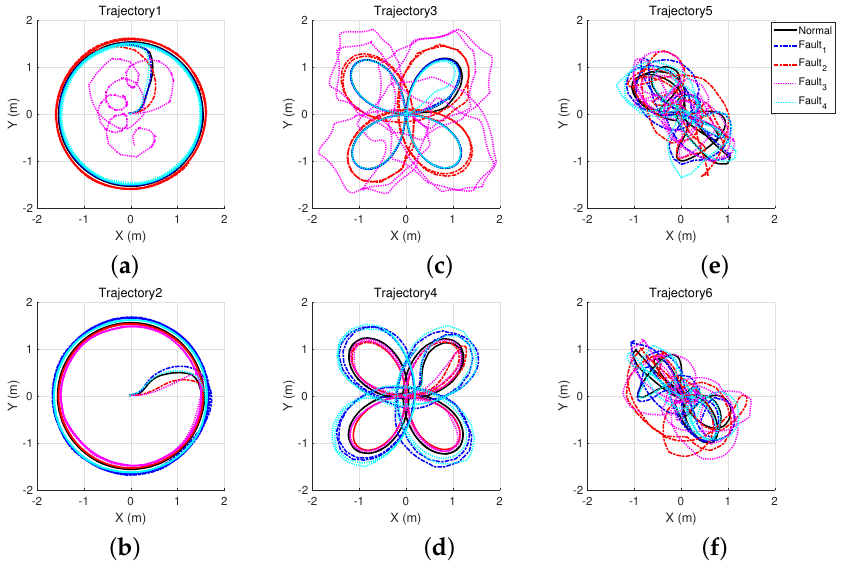
Figure 9. Experiment data with disturbance. Normal is no fault condition, Fault 1 is the first actuator fault, Fault 2 is the second actuator fault, Fault 3 is the third actuator fault, and Fault 4 is the fourth actuator fault. ( a ) Circular (CCW). ( b ) Circular (CW). ( c ) Clover (CCW). ( d ) Clover (CW). ( e ) Modified Clover (CCW). ( f ) Modified Clover